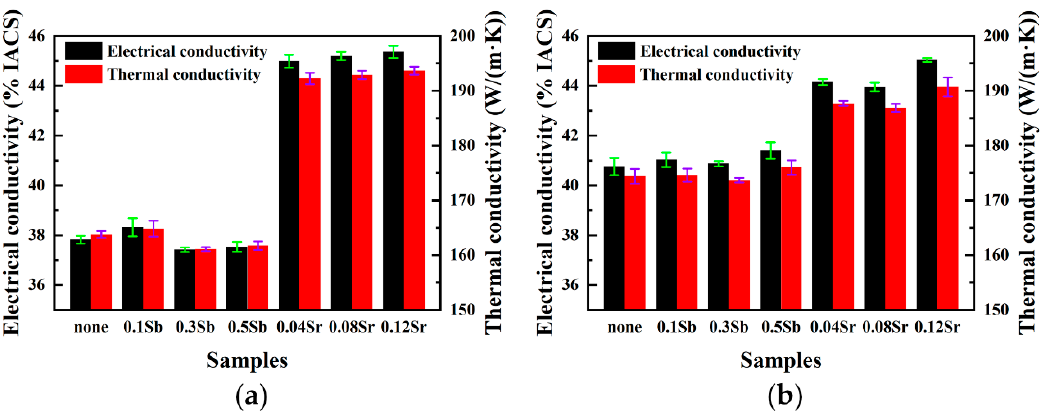
Figure 6. Electrical and thermal conductivities of Al-8Si alloys in different states: ( a ) electrical and thermal conductivity of as-cast alloys, ( b ) electrical and thermal conductivity of T6 state alloys.